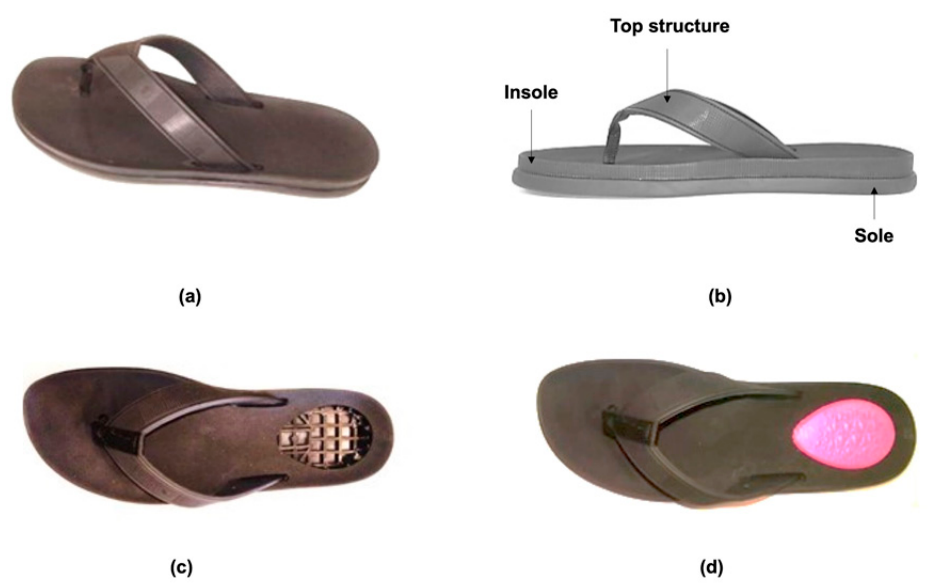
Figure 11. Slippers used in the case study: ( a ) original TPU slipper; ( b ) structure of the slippers; ( c ) prototype slipper with a cut in the insole heel zone for insert placement; ( d ) prototype slipper with insert.